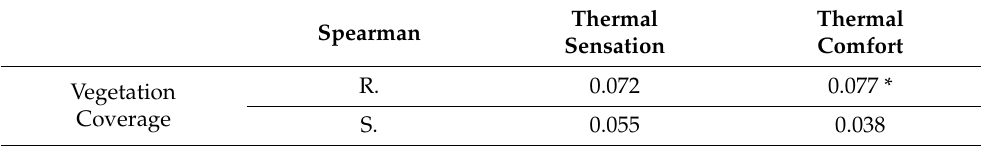
Table 9. Spearman correlation of vegetation cover with thermal sensation and thermal comfort.